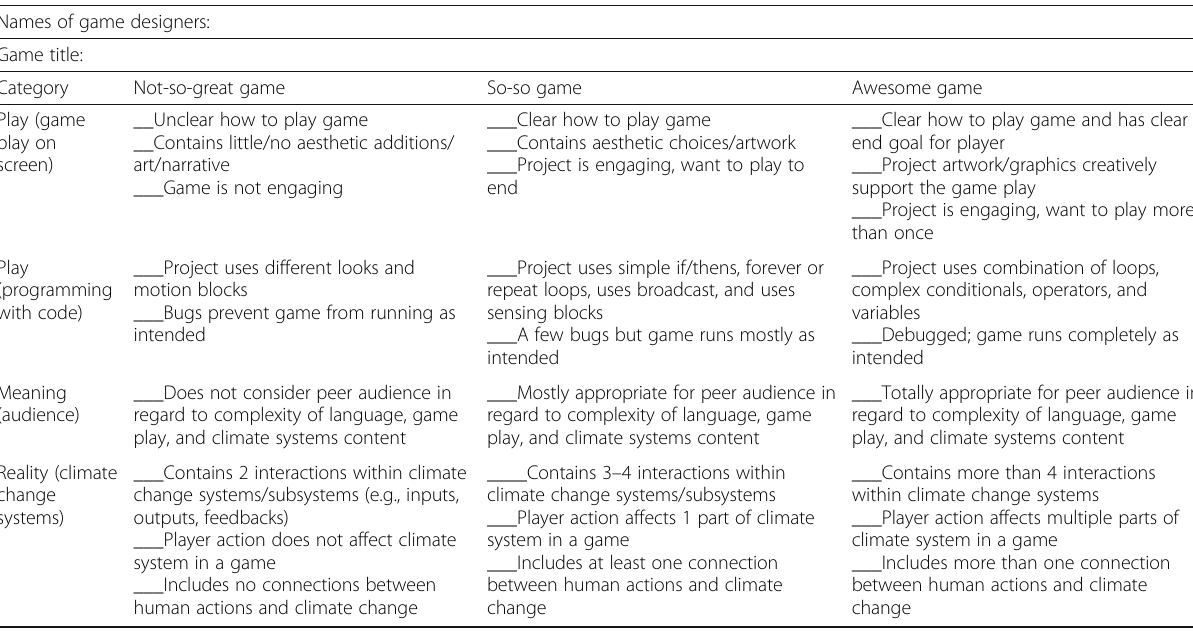
Table 2 Game design rubric Building systems rubric for game designers Names of game